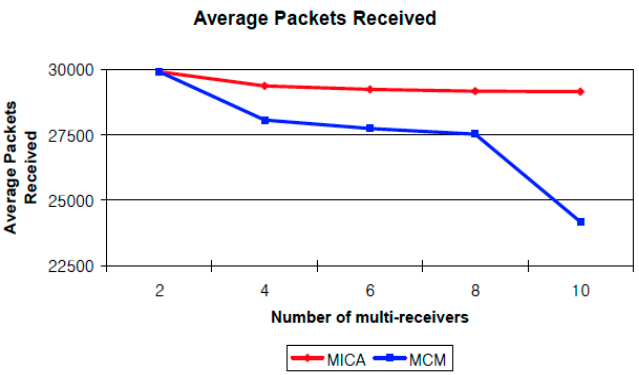
Figure 6. Impact of a different number of multi-receivers.